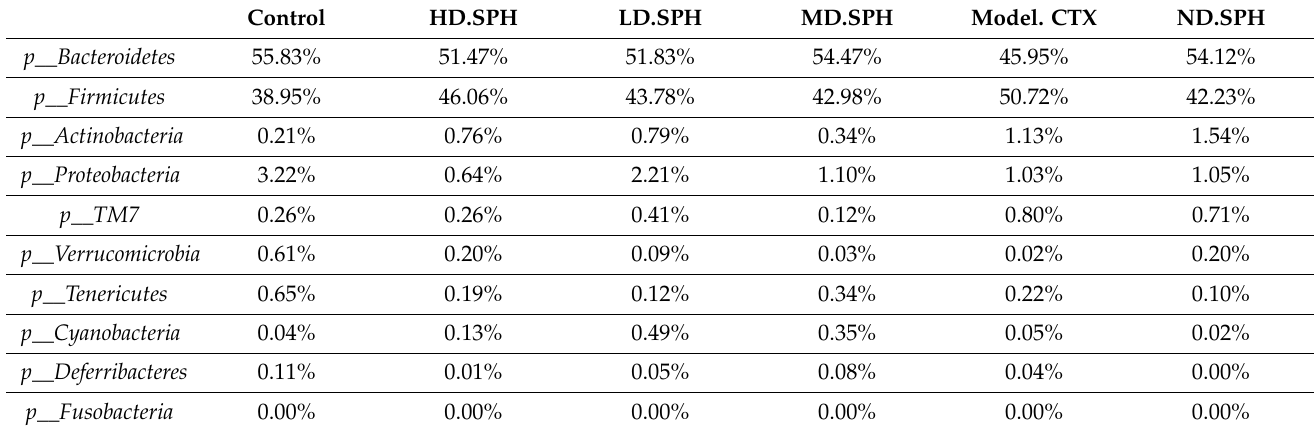
Table 1. Different treatment groups’ percentages of bacterial